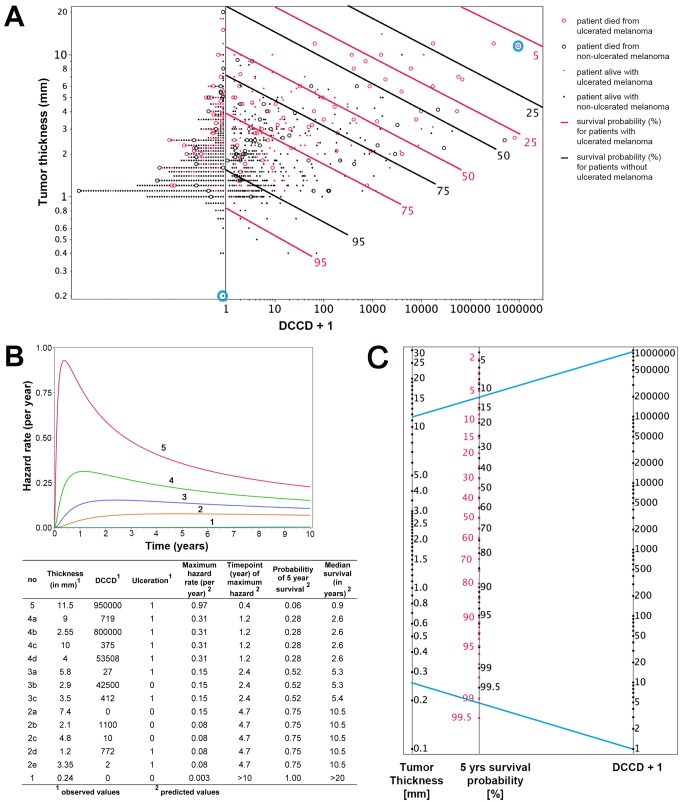
Individualized risk estimation over time.(A) The predicted 5-y survival by DCCD, tumor thickness, and ulceration for all 1,027 patients. Dots indicate patients who were alive at the end of follow-up; circles indicate patients who died from melanoma (n = 138). The red symbols indicate patients with ulcerated melanomas. The patients left of the vertical line at DCCD + 1 = 1 (n = 502) displayed no DCCs in their sentinel nodes. Dots located on the same continuous line represent patients with the same 5-y survival, which is depicted at the right end of the lines (red lines for the patients with ulcerated melanoma). For example, for Patient 1 and Patient 5 from (B) (circled in blue), the estimated 5-y survival of Patient 1 is >99.5%, while for Patient 5 it is about 6%. The parametric survival model is based on the lognormal distribution and includes DCCD, thickness, and ulceration. (B) Time-dependent hazard rates for 14 individual patients with five different hazard rates (1–5) with their observed thickness, DCCD, and ulceration status, and their corresponding predicted 5-y survival rates and median survival times. Different combinations of thickness, DCCD, and ulceration status may indicate the same risk of death from melanoma. In contrast to the Cox model, the predicted hazard ratios vary over time. (C) A nomogram enables estimating the 5-y survival probability. The 5-y survival probability is the value at the intersection of a straight line connecting DCCD and tumor thickness with the central straight line. For illustration, the blue lines exemplify the same Patients 1 and 5 that are marked in (A) and described in (B). Patient 5 had an ulcerated melanoma, and therefore the red scale must be used, while Patient 1 had a non-ulcerated melanoma, so survival probability is given on the black scale. Note that the nomogram has not been independently validated and therefore is not yet suitable for clinical use.